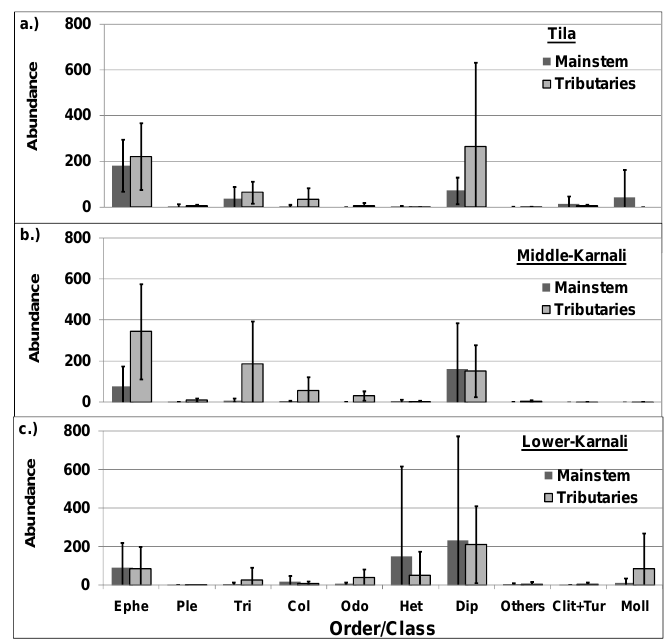
Figure 5. Benthic macroinvertebrate abundance across different taxonomic groups in the river’s mainstem and the tributaries of the studied watersheds ( a . Tila, b . Middle-Karnali, c . Lower-Karnali ) .Ephe: Ephemeroptera, Ple: Plecoptera, Tri: Trichoptera, Col: Coleoptera, Odo: Odonata, Het: Heteroptera, Dip: Diptera, Others: Decapoda, Megaloptera and Lepidoptera, Clit+Tur: Clitellata+Turbellaria; Moll: Mollusca. NMDS revealed two distinct clusters representing mountain and lowland sites (Figure 6).